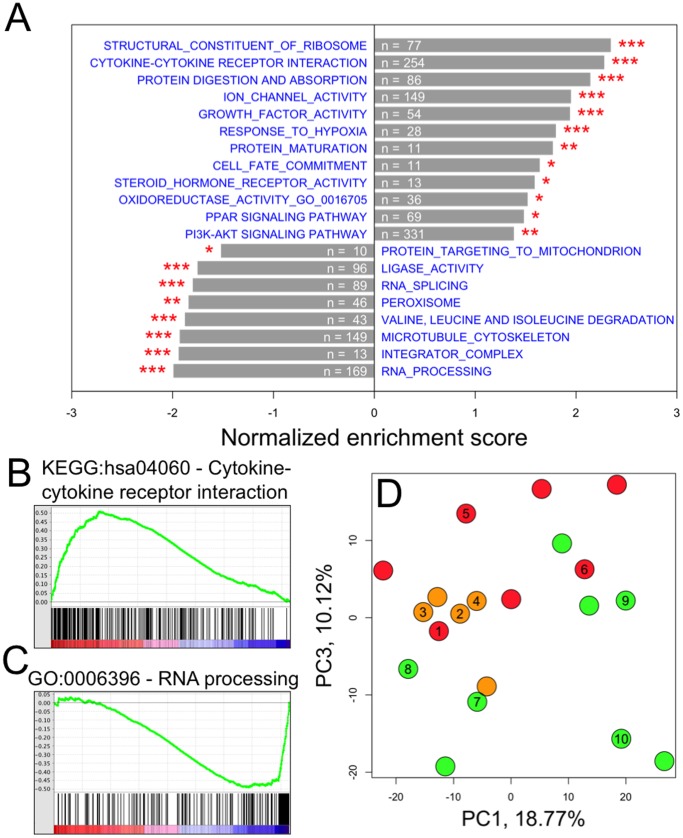
Differential gene expression in RC disease FCL.(A–D) Differential expression of the same GSEA-defined pathways are shown for RC disease versus control FCLs as identified in skeletal muscle in Fig. 2 (See File S2 for complete results). Positive and negative enrichment scores, respectively, indicate up- and down-regulation in RC disease. Numbers indicate counts of genes in each gene set that were measured by our experiment. * p<0.05; ** p<0.01; *** p<0.001. (B) The “Cytokine-cytokine receptor interaction” gene-set was identified in GSEA as among the most up-regulated gene sets in RC disease FCLs. (C) RNA processing pathway genes were generally down-regulated in RC disease FCLs. (D) Unsupervised clustering via principal component analysis (PCA) identified distinctive transcriptome groupings among FCLs from subjects categorized as color-detailed and defined in Fig. 1, where numbered circles indicate subjects also studied in the muscle data set (Fig. 2D).